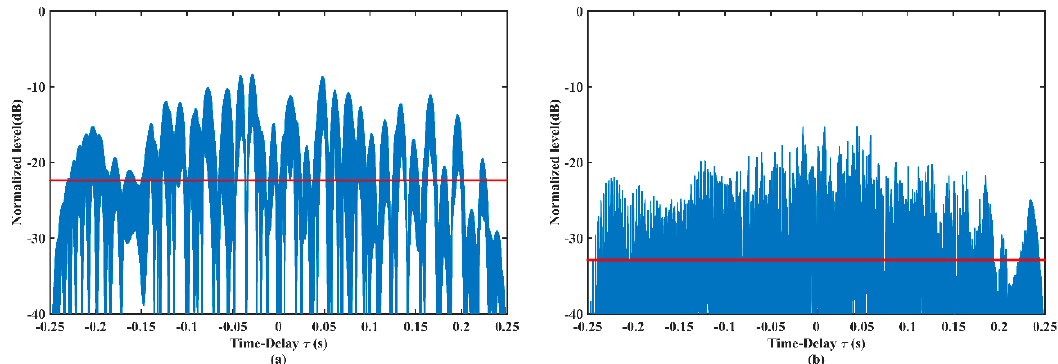
Figure 8. Cross-correlations of ( a ) the initial GSFM pulses and ( b ) the optimized GSFM pulses. ( a ) is the cross-correlation between initial pulses with the normal instantaneous-frequency and the even-symmetric instantaneous-frequency, while ( b ) is the cross-correlation between pulse 1 and 2 with α = 1966, ρ = 2.21 and α = 1877, ρ = 2 2 1 1